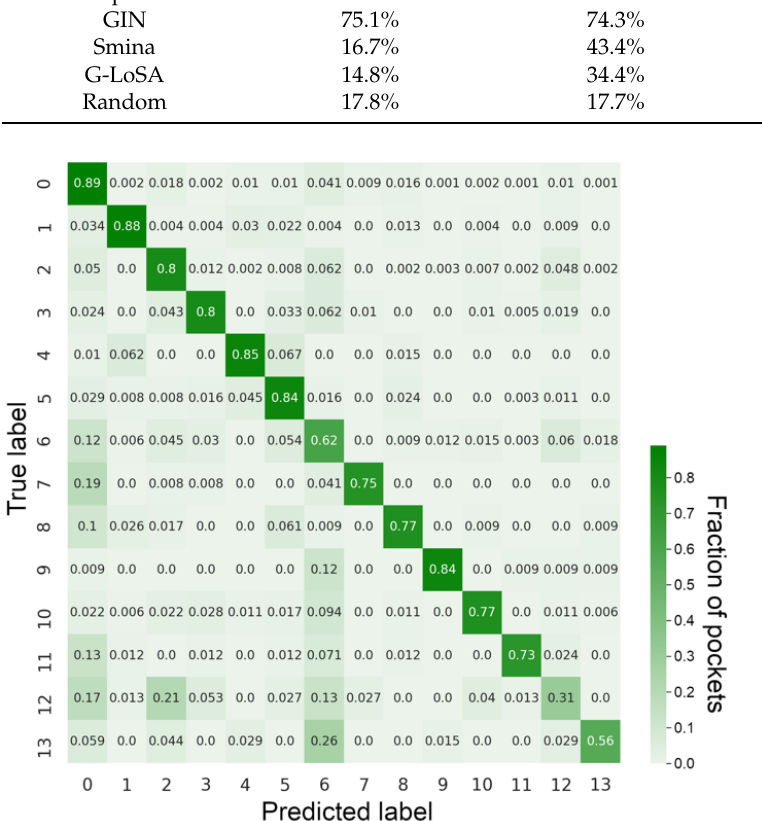
Figure 3. Confusion matrix for classification with GraphSite on the benchmarking dataset. Each row of the confusion matrix is normalized. Numbers on the diagonal correspond to the recall of each class, while other numbers indicate the fraction of misclassified pockets.